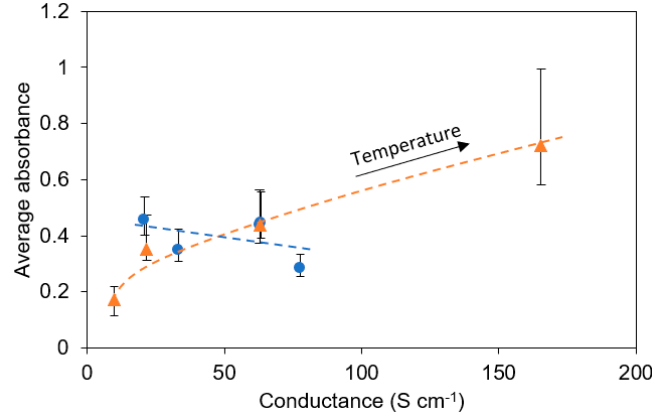
Figure 7. Dependency of the average absorbance on the conductivity of B-CNWs deposited on fused quartz.